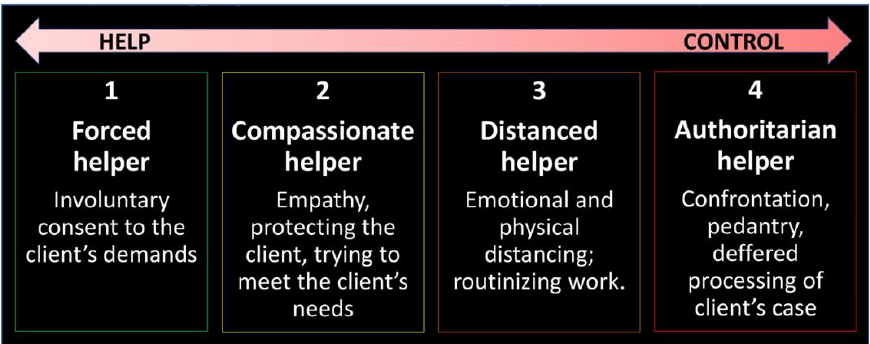
Figure 1. Social workers’ perceived professional role in different coping